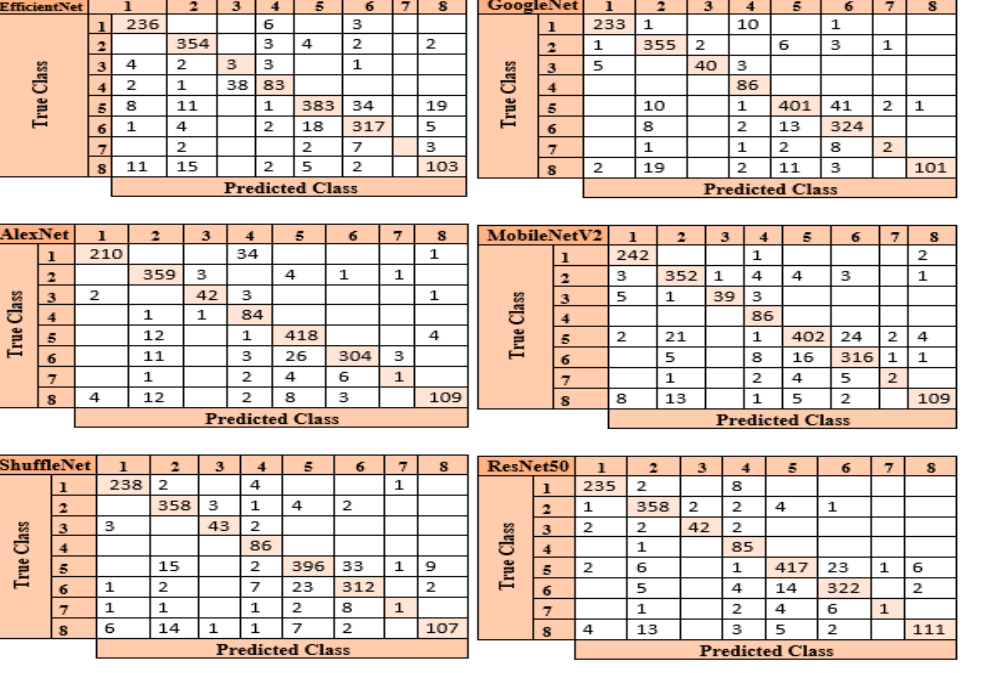
Figure 5. Confusion matrices of the pre-trained models.